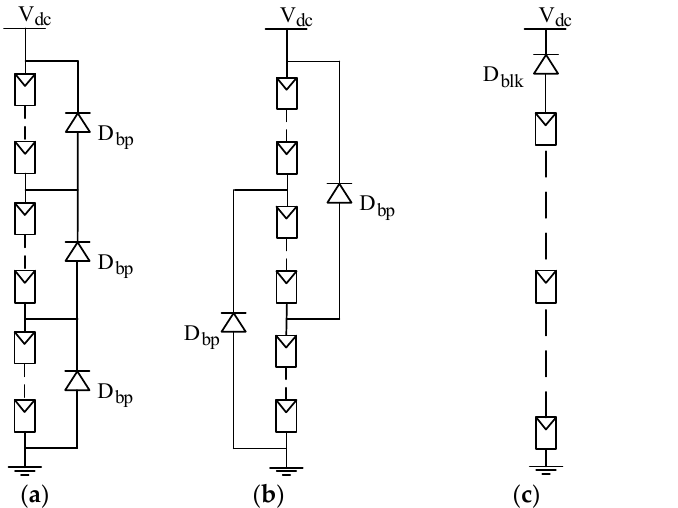
Figure 2. Diodes’ interconnections in PV modules: non-overlapping bypass diodes ( a ); overlapping bypass diodes ( b ); blocking diode connection ( c ).